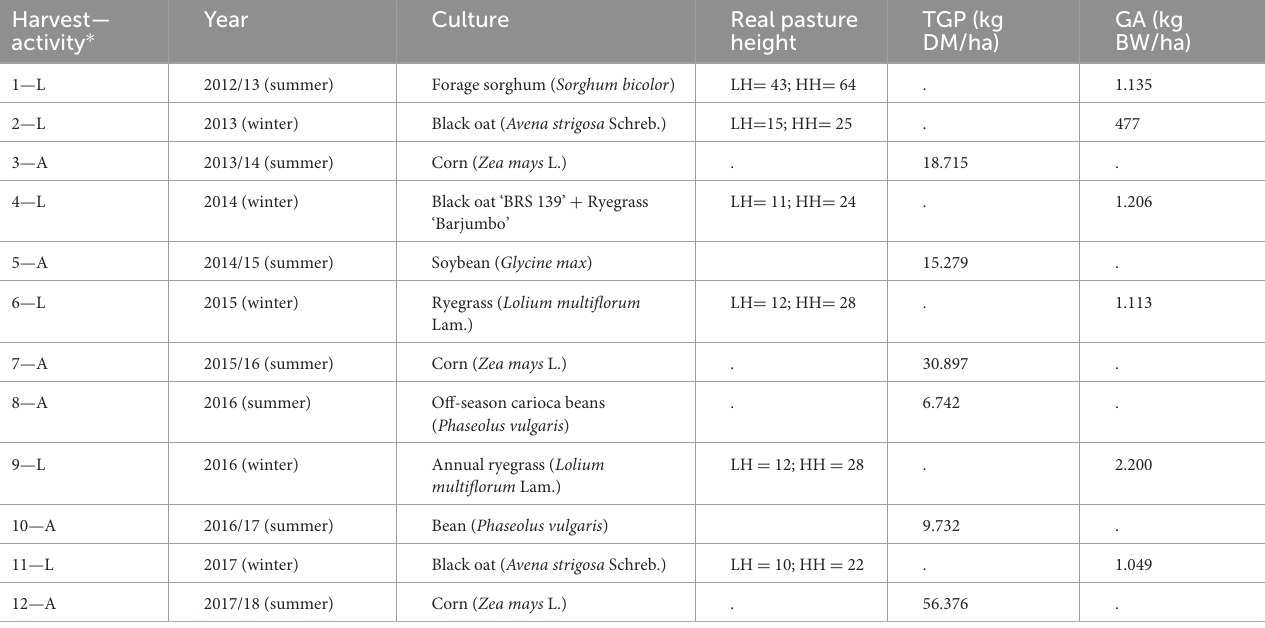
TABLE 1 Background of cultures used during all years/periods since the implementation of the experiment in Abelardo